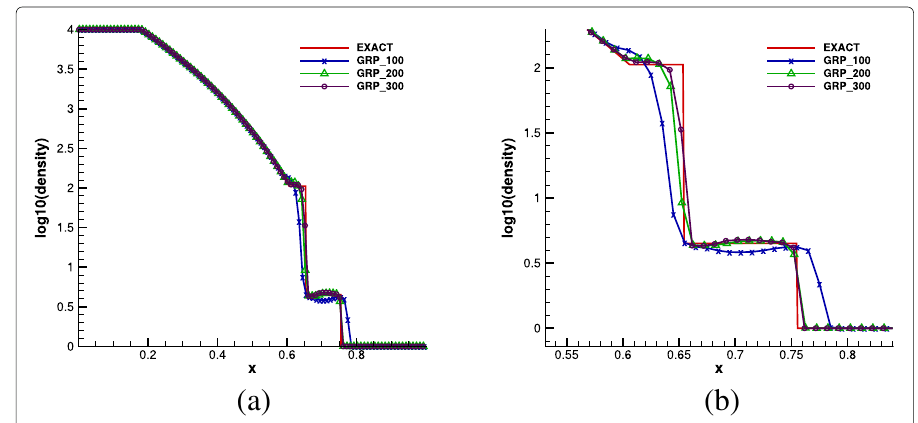
Fig. 2 The GRP simulation (only 100 cells are shown). a GRP with relatively small number of grid points. b Zoomed solution